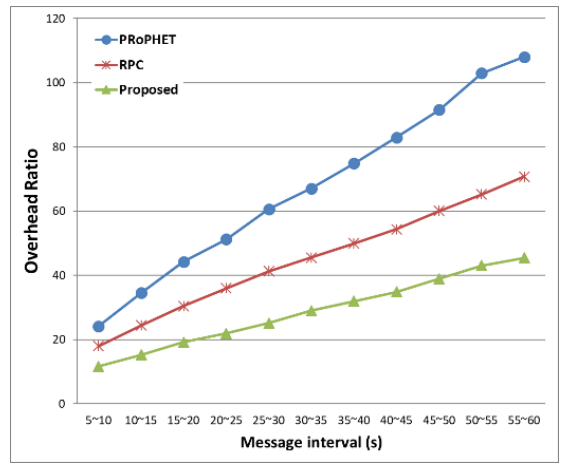
Figure 9. Overhead ratio for different message intervals.